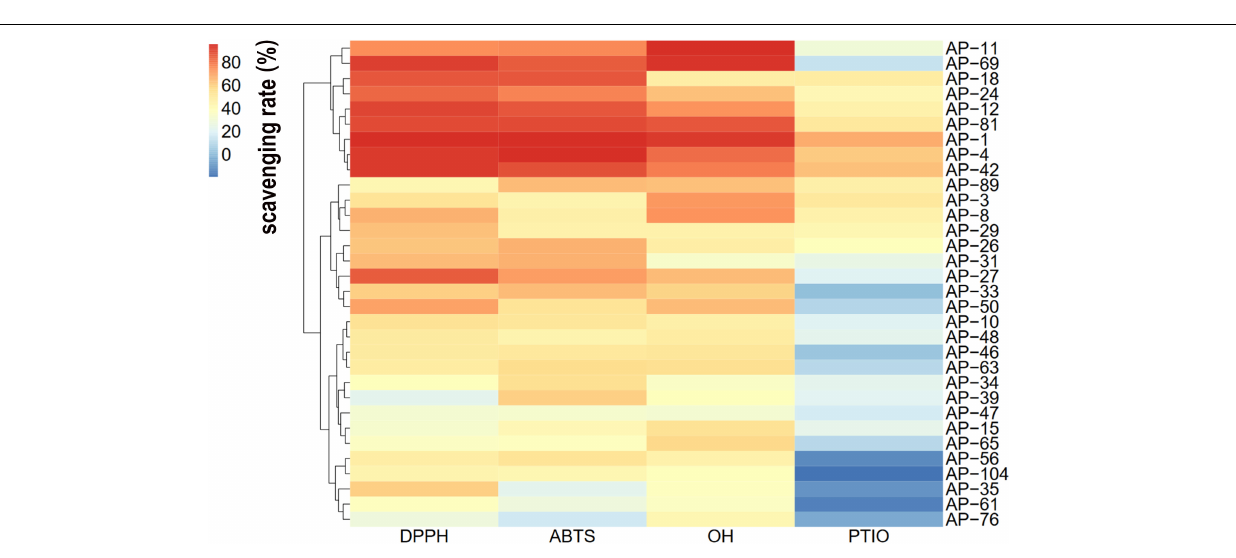
identification, 32 strains from Colletotrichum sp., Hypoxylon sp., Nodulisporium sp., Diaporthe sp., and Peroneutypa sp. were